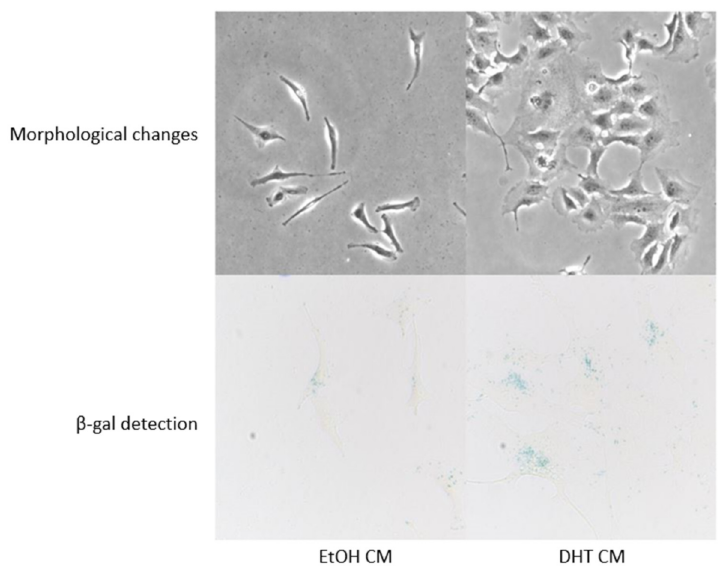
Figure 8. Effect of senescent 84E7 cells’ conditioned medium on untreated 84E7 cells. Conditioned medium obtained from 84E7 cells treated with 10 nM DHT for 6 days induced paracrine senescence in untreated 84E7 cells. Images were taken at 40 × magnification.